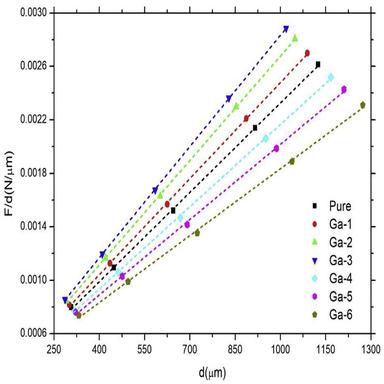
Change of applied test load F/d versus diagonal length d belonging to every material.